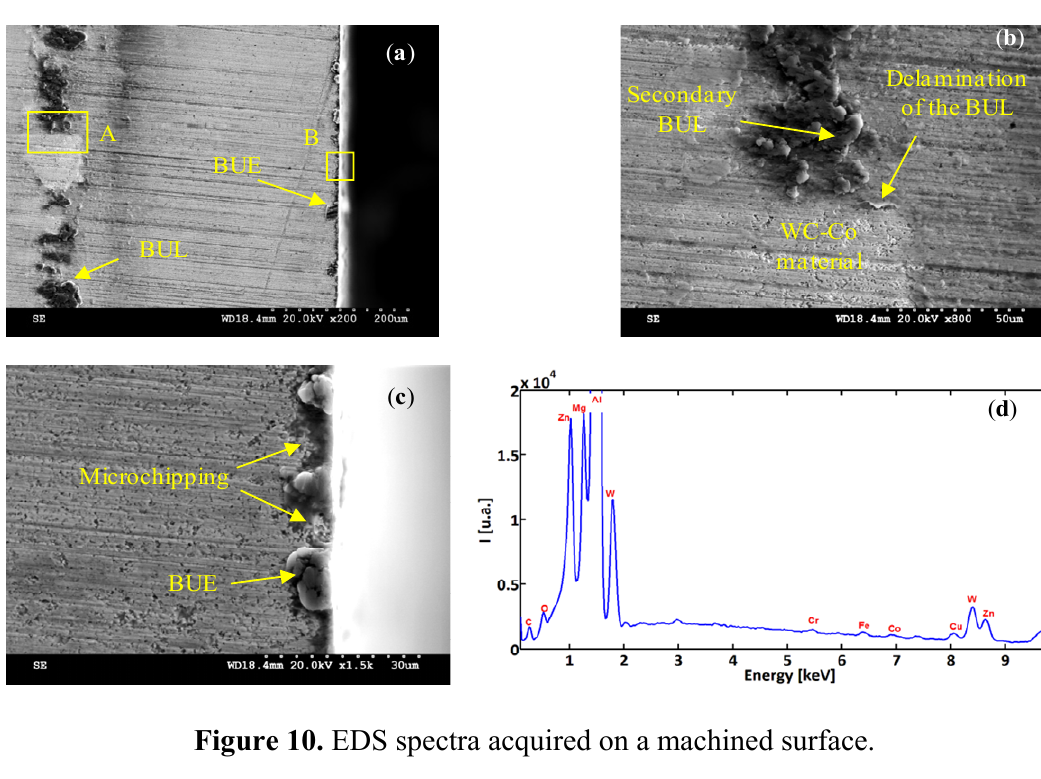
Figure 9. ( a ) Rake face of the cutting insert for Trial #4; ( b ) BUL-Detail A; ( c ) micro-chipping of the tool edge Detail B and ( d ) EDS spectra acquired on secondary BUL.